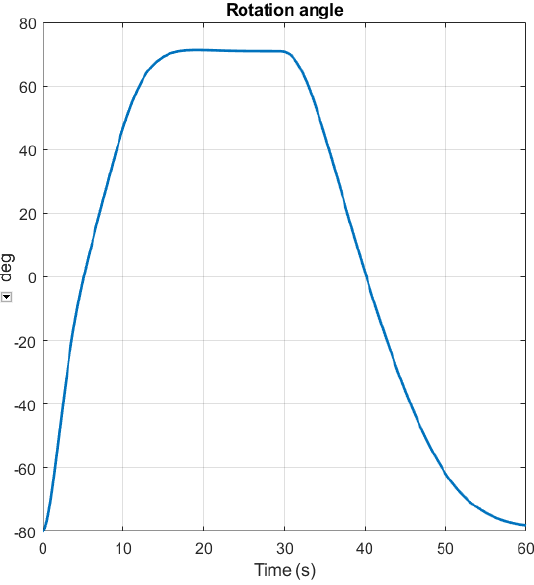
Figure 11. Varia tion versus time of the rotation angle of lever AB. Figure 12. Variation versus time of the angular velocity of